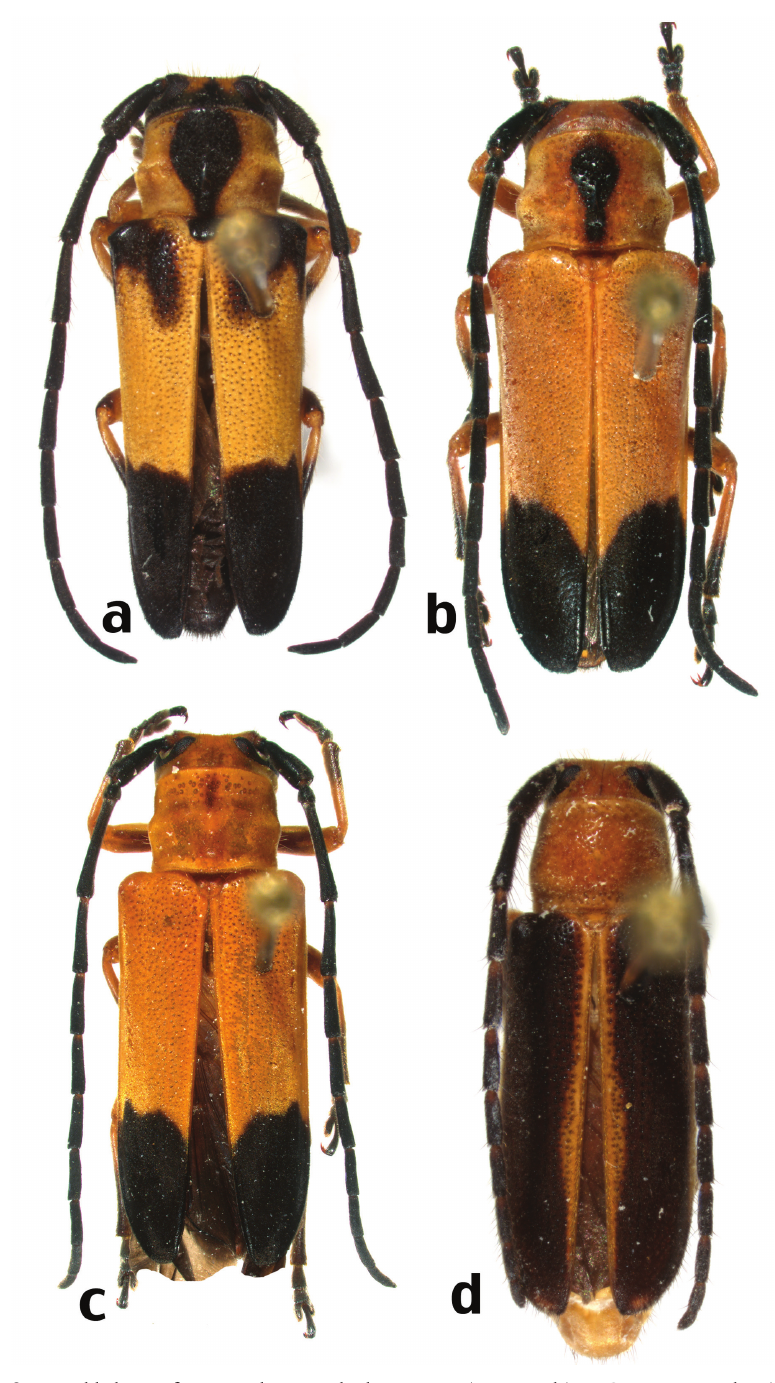
Figure 9. Dorsal habitus of Hispaniolan Hemilophini species (not to scale): a C. nigritarsis Fisher (morpho- type 1) b C. nigritarsis Fisher (morphotype 2) c C. nigritarsis Fisher (morphotype 3) d C. semimarginatus